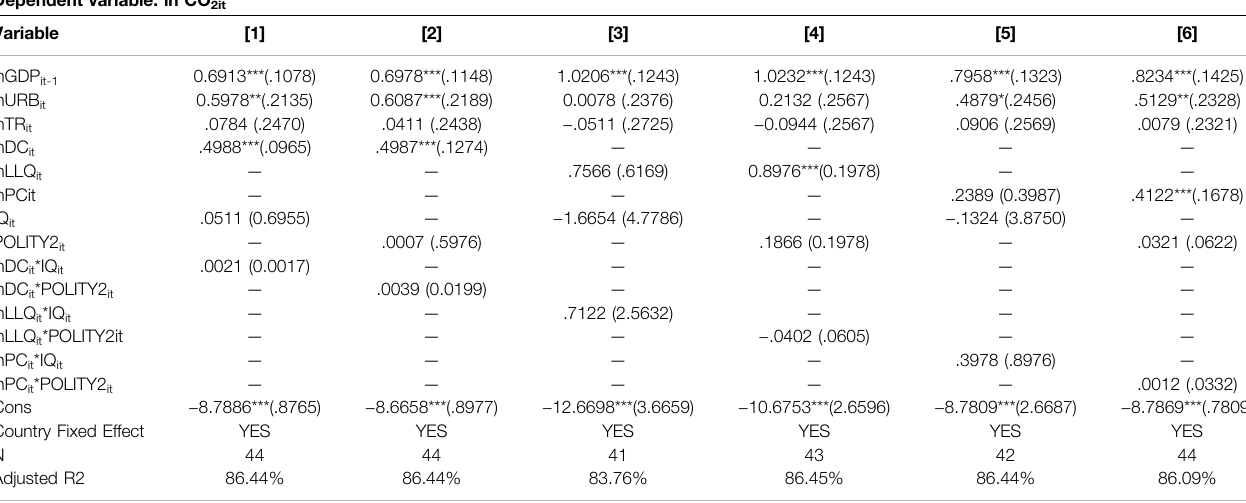
Tables 4 – 6 demonstrate the cross-county regression relationships between variables.